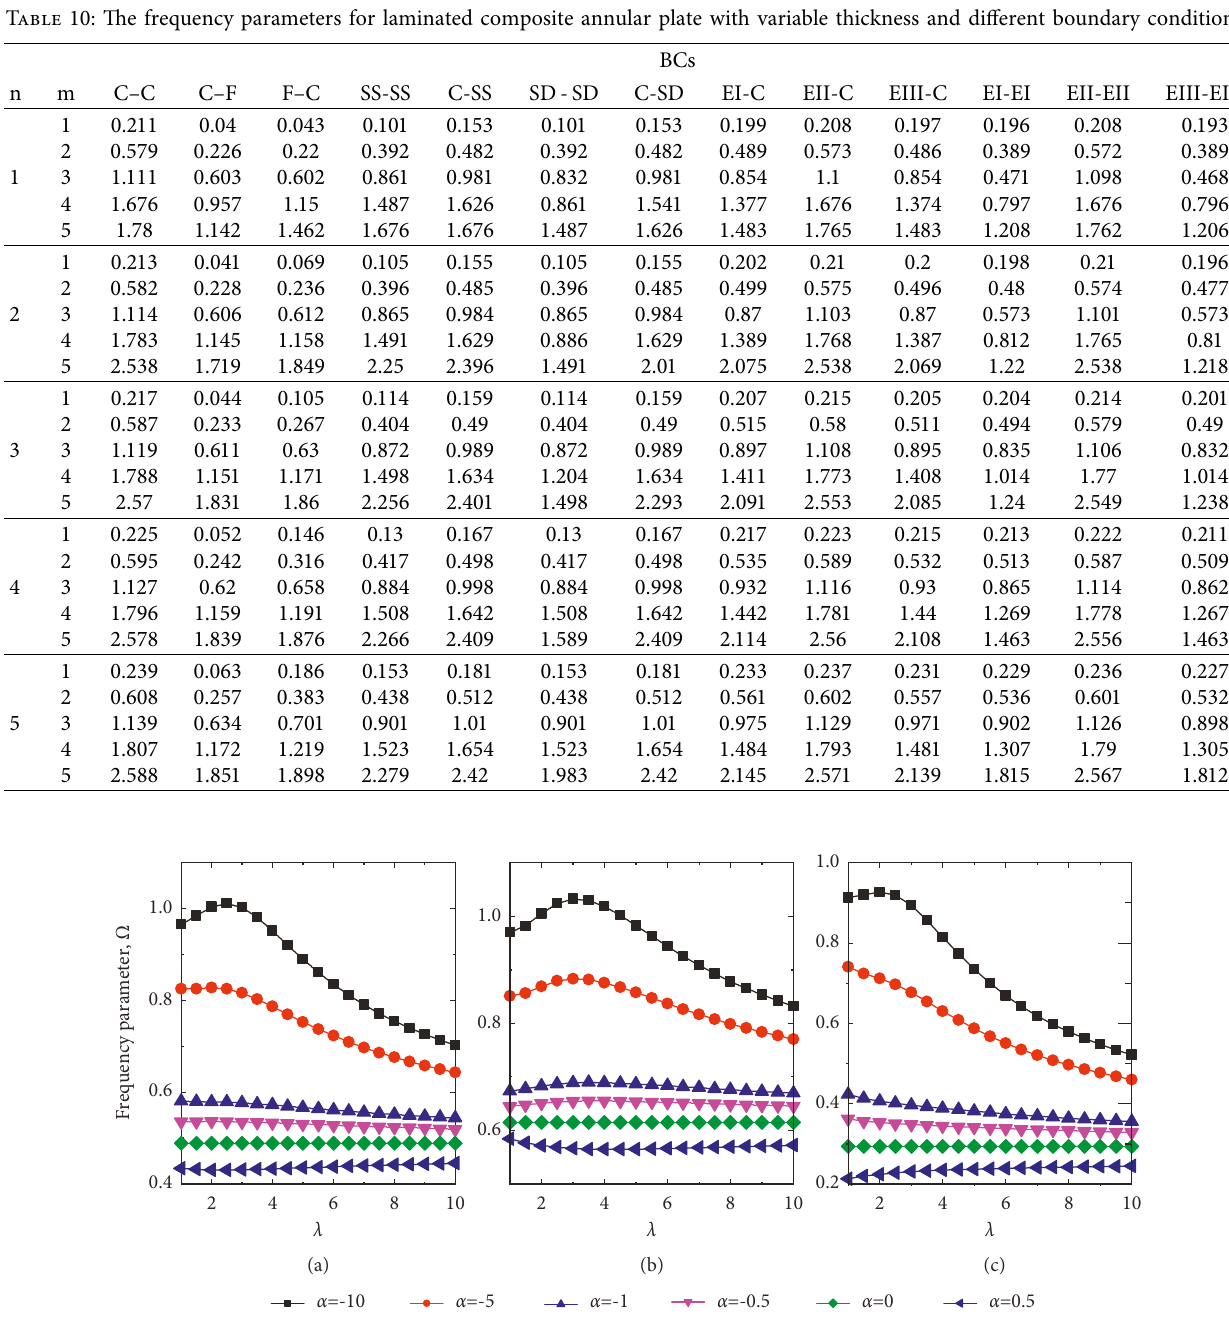
Table 10: The frequency parameters for laminated composite annular plate with variable thickness and different boundary conditions.